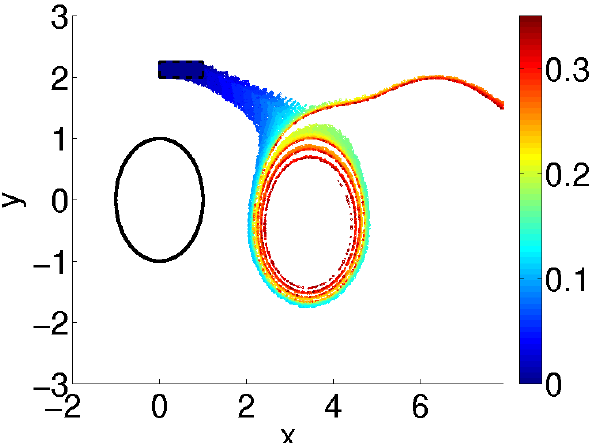
Fig. 9. Tracers released in the upwelling region [ 0 , 1 ]×[ 2 , 2 . 25 ] at t = 5 . 84 T c . The colors denote the time they have been in the observation region (backward residence time).